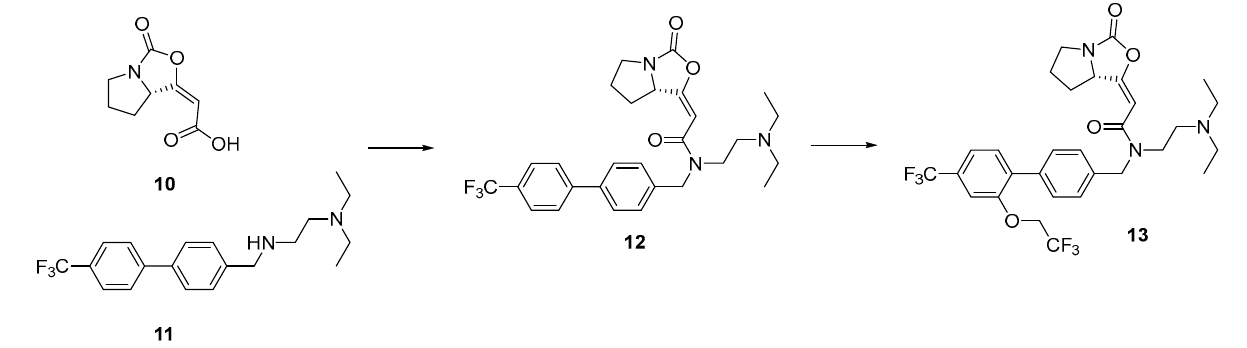
Figure 7. Fragment merging and elaboration of LP-Pla2 small molecule inhibitors.